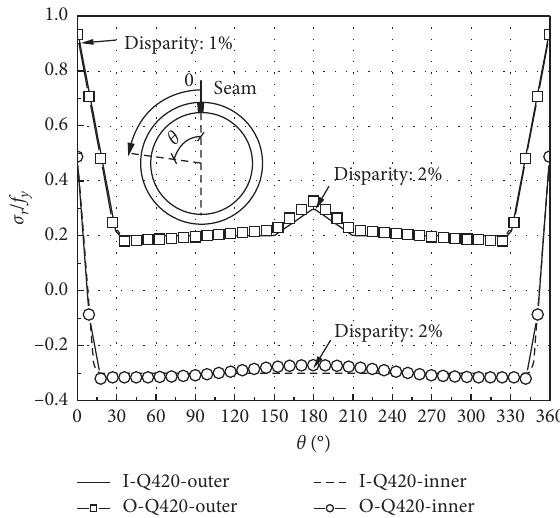
Figure 5: Residual stresses distribution of Q420 welded tubes [10].